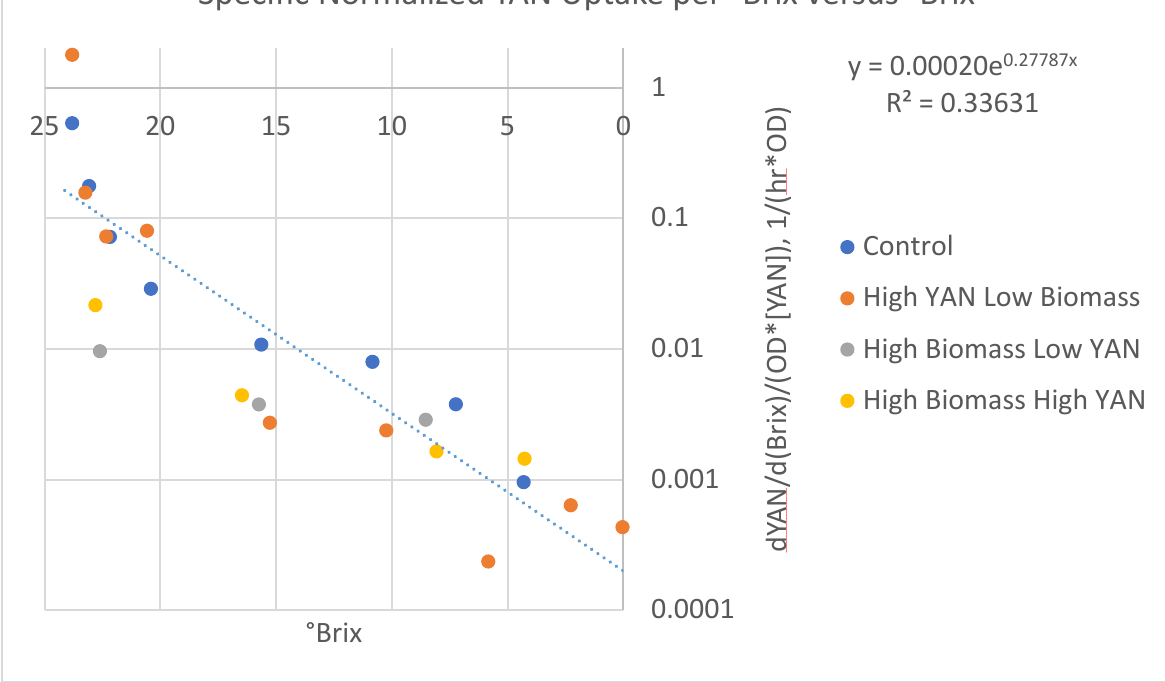
Figure 1. Consumption of YAN as a function of fermentation progression, current optical density, and current YAN. Data points captured 2x/day over the course of flask fermentations. Integrating the resultant exponential fit results in Equation (1), which estimates the maximum YAN that the current biomass concentration can consume before the end of fermentation with only 30 mg/L YAN residual: